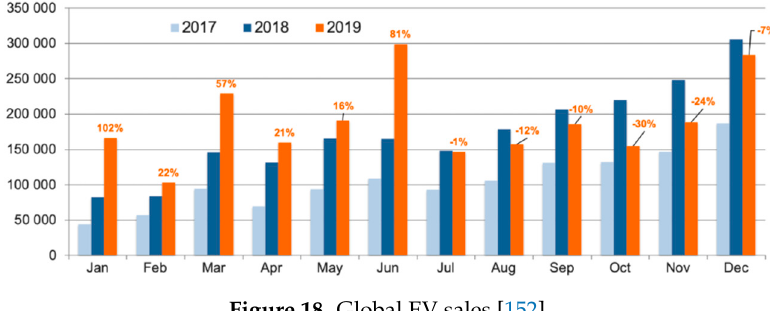
Figure 18. Global EV sales [153].